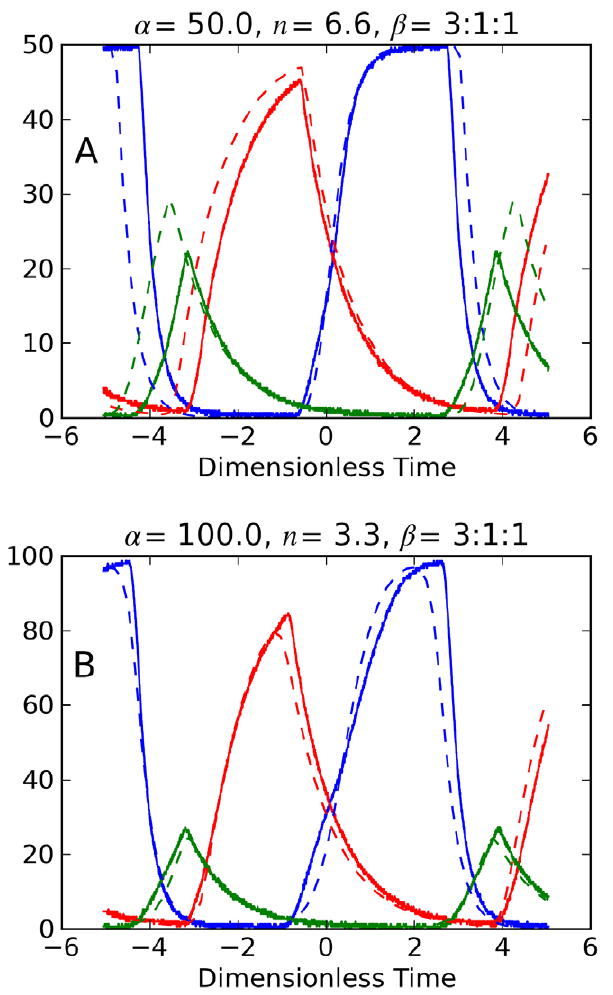
Figure 7. Electronic repressilator dynamics with one slow decay rate. Normalized voltages x i measured from RGN repressilator circuit (solid) and numerical predictions (dashed). b -ratio =0.3:1:1. Panel A ( a =50, n =6.6); Panel B ( a =100, n =3.3).